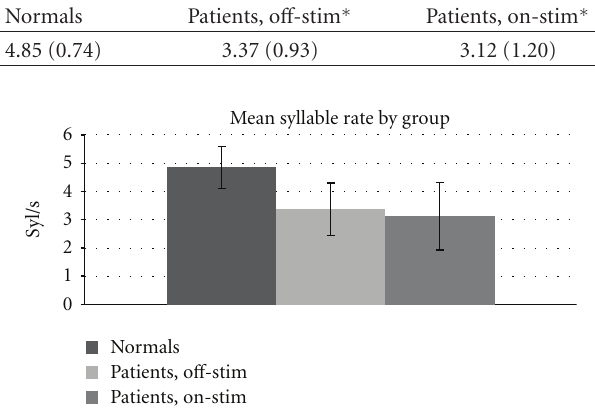
Table 1: Syllable rate (syl/sec.) by group. Mean (and standard deviation) are shown for each group. ( ∗ = di ff erence from normal significant at P ≤ . 001).